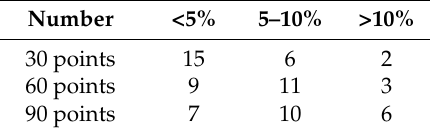
Table 4. Test results of other transformers (%).